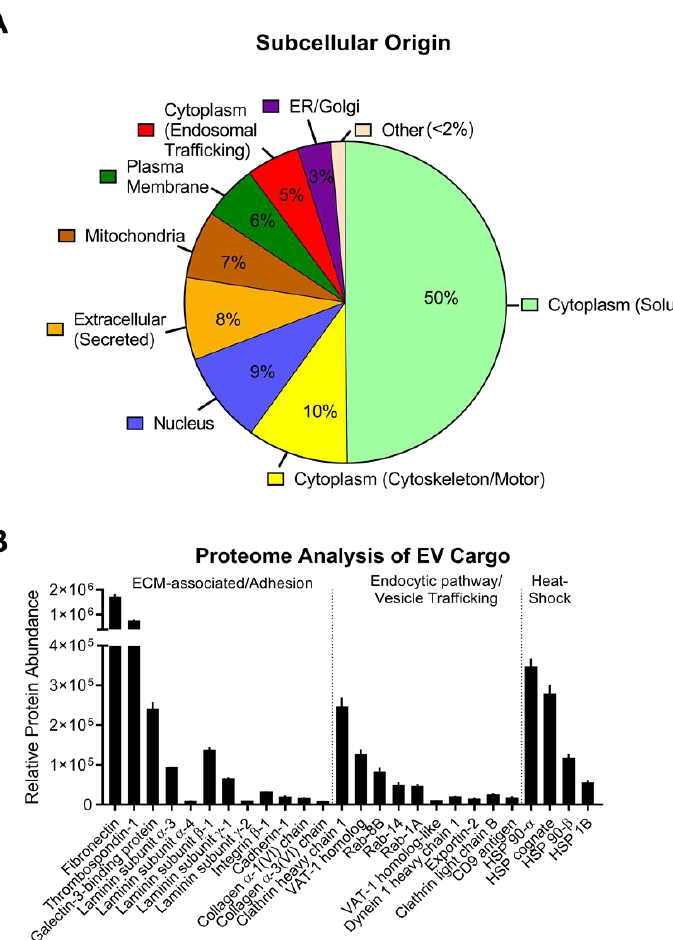
Figure 7. Protein cargo identified in unwounded hCE-TJ-derived EVs by proteomic analysis. ( A ) Proteins identified in isolated hCE-TJ EVs categorized by the dominant subcellular origin and classified based on nine major subcellular locations according to the UniProtKB database [53]. A full list of the proteomics data can be found in Table S1. ( B ) Distribution of select proteins identified in hCE-TJ-derived EV proteome. n = 3. Error bars represent SEM.